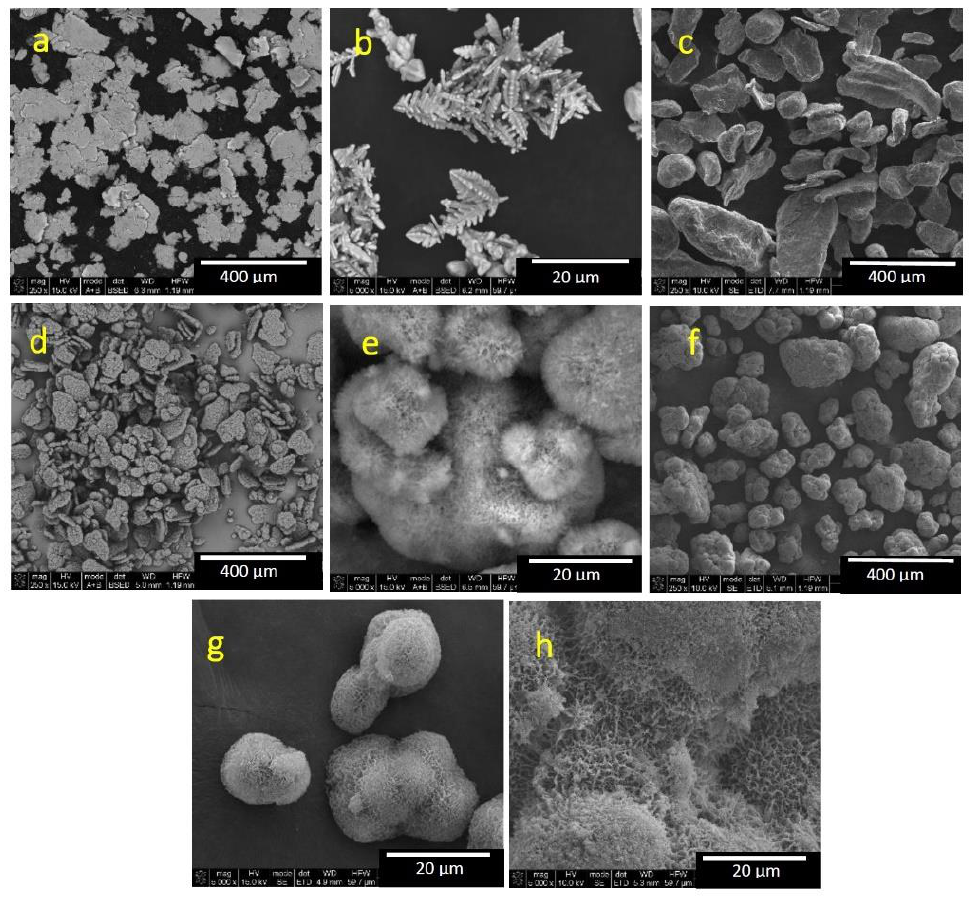
Figure 1. SEM micrographs of neat metal particles and Me-MPs: ( a ) Al; ( b ) Cu; ( c ) Mg; ( d ) Al10; ( e ) Cu10; ( f ) Mg10; ( g ) PA6; ( h ) close view of Mg10. For sample designations see Table 1.